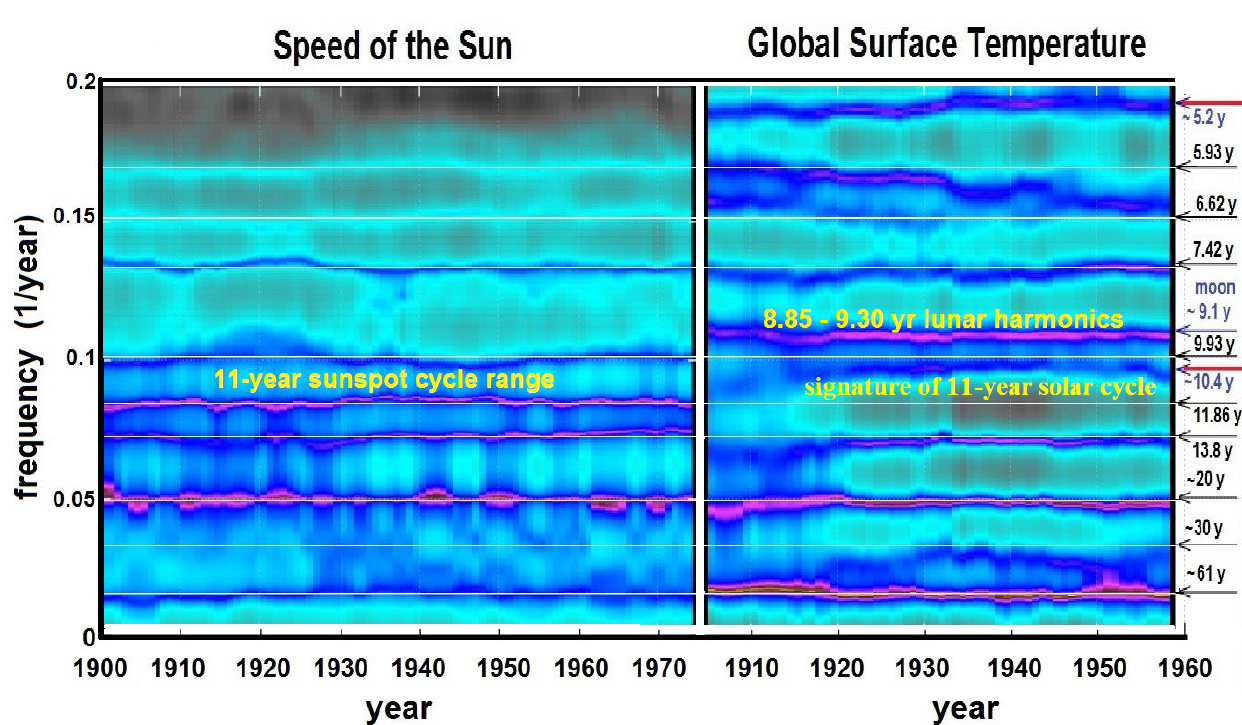
Figure 13. Comparison of the time-frequency analyses between the speed of the sun relative to the center of mass of the solar system ( left ) and of the HadCRUT global surface temperature record ( right ). Details are found in Scafetta